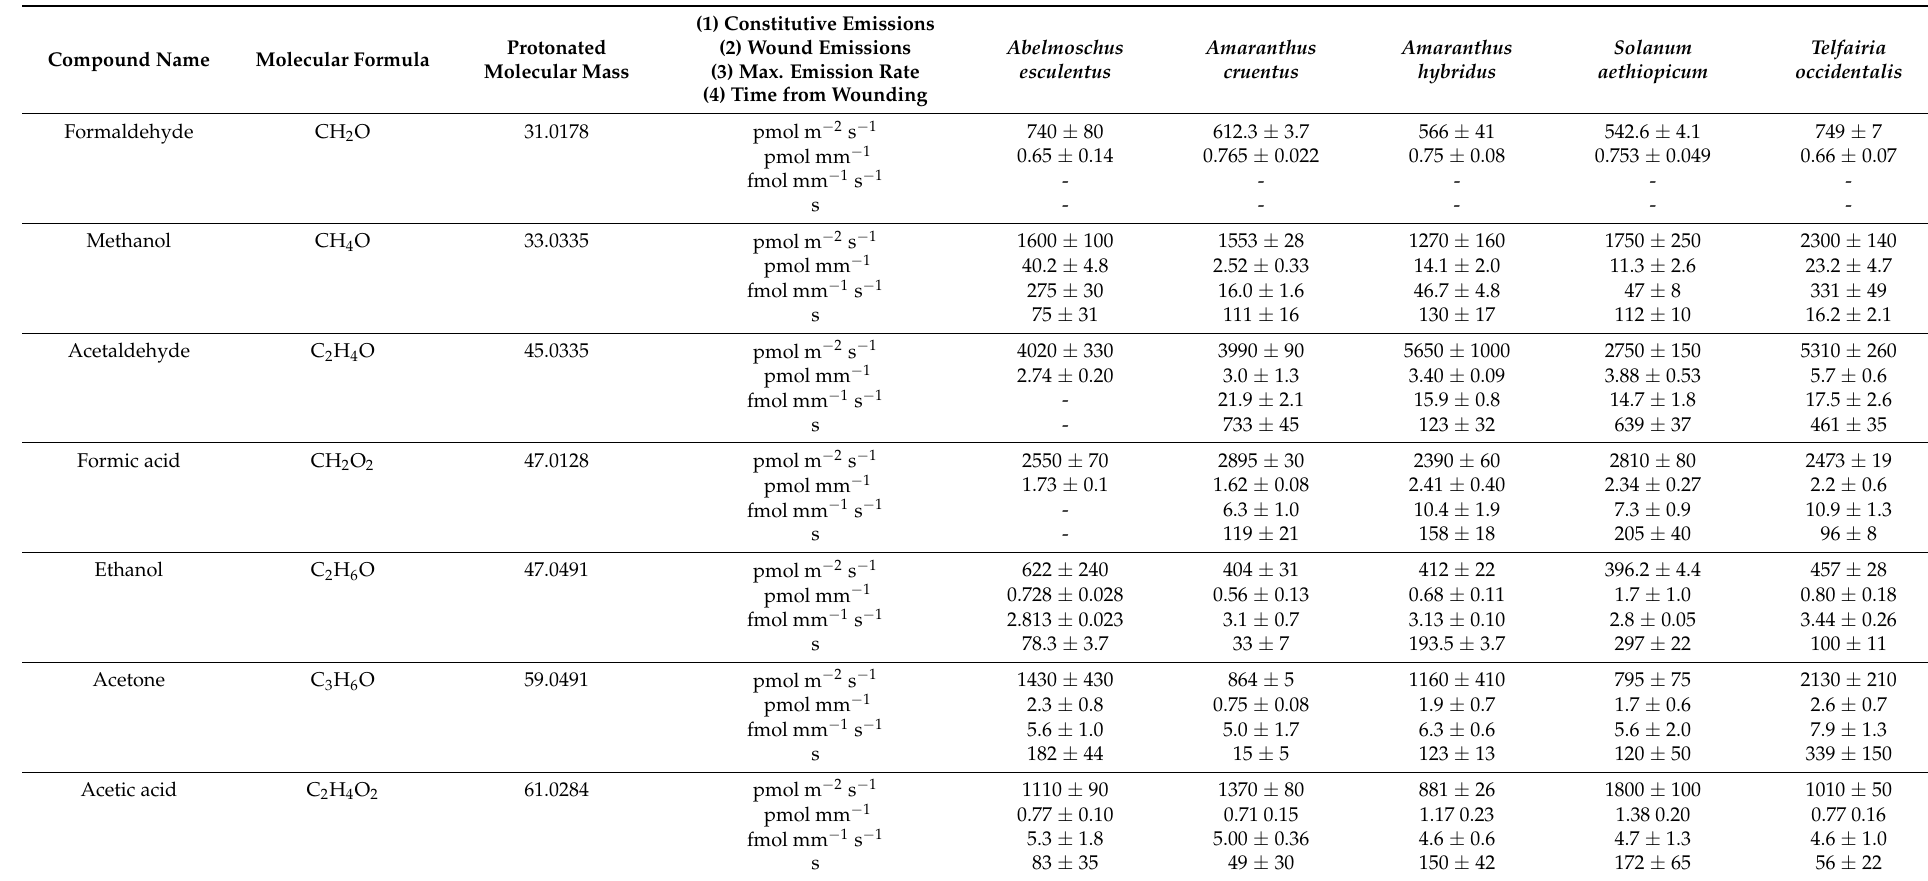
Table 2. Volatile organic compound (VOC) emissions (average ± SE) of five tropical crop species in (1) at optimal conditions of light, air temperature and moisture (constitutive emissions), and (2) after a 12 mm cut was made into the leaf lamina. The VOC emission rate (3) at the wounding-induced peak maximum and (4) the time to the peak maximum are also provided when the pattern of VOC emissions after wounding included a peak. Information on individual contributions to the total emissions in percentage is in Table